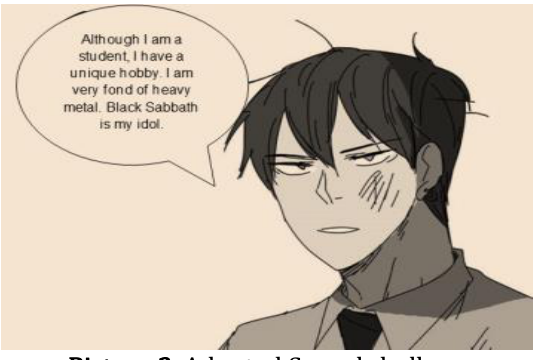
Picture 2. Adapted